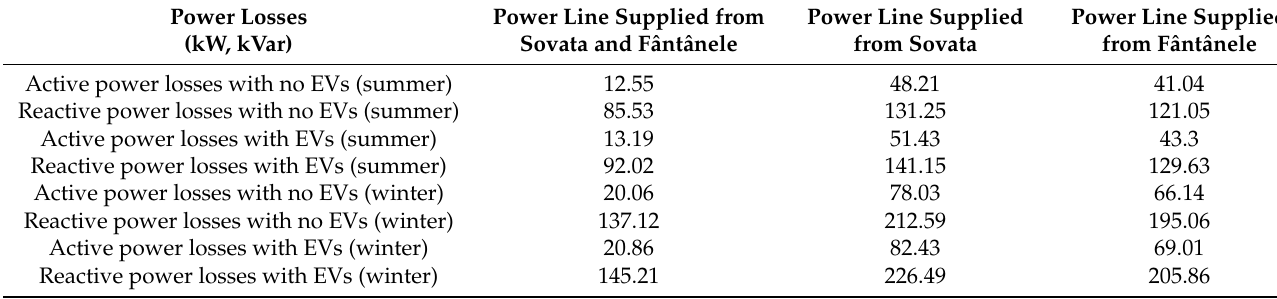
Table 9. Power losses at 3:00 (scenario